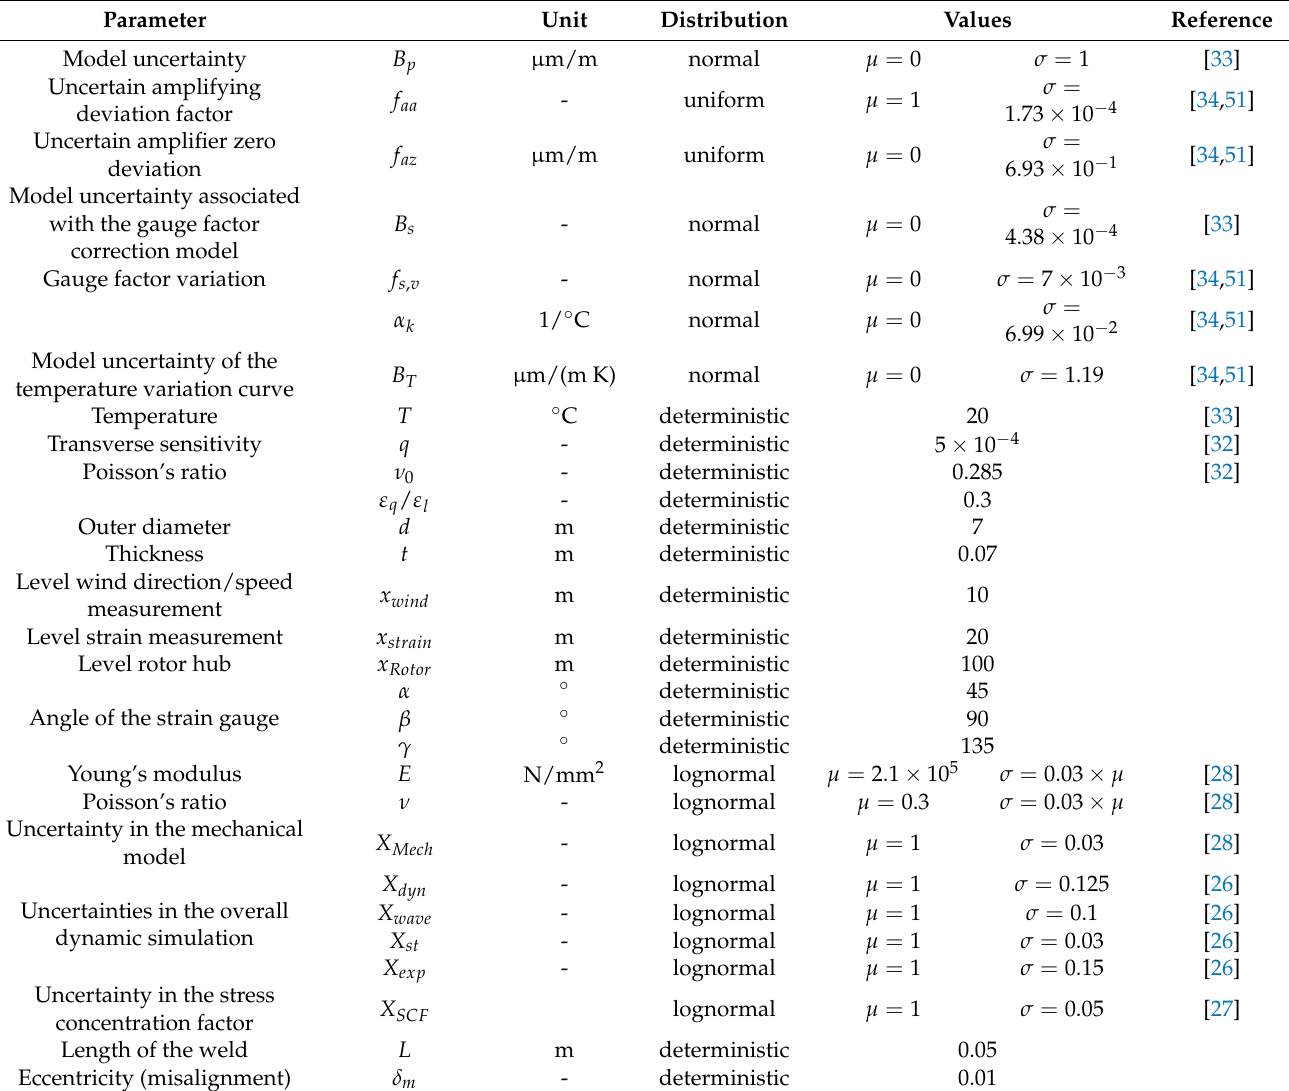
Table 3. Probabilistic and deterministic parameters for the calculation for the predicted posterior stress